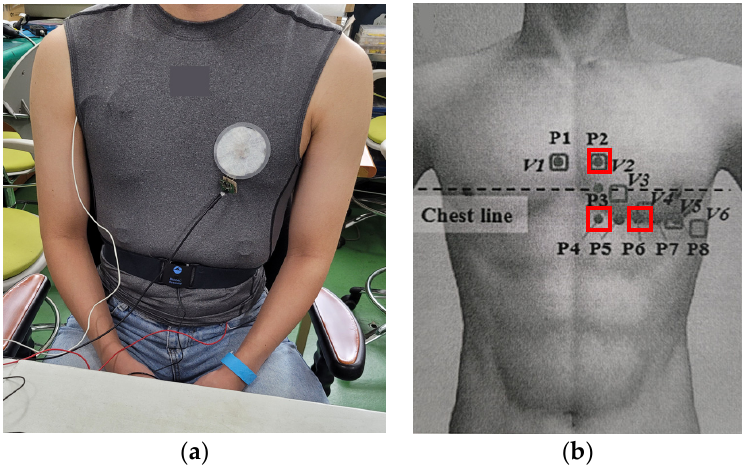
Figure 5. Cardiac activity and respiration signal acquisition experiment: ( a ) experimental image, ( b ) measurement position.